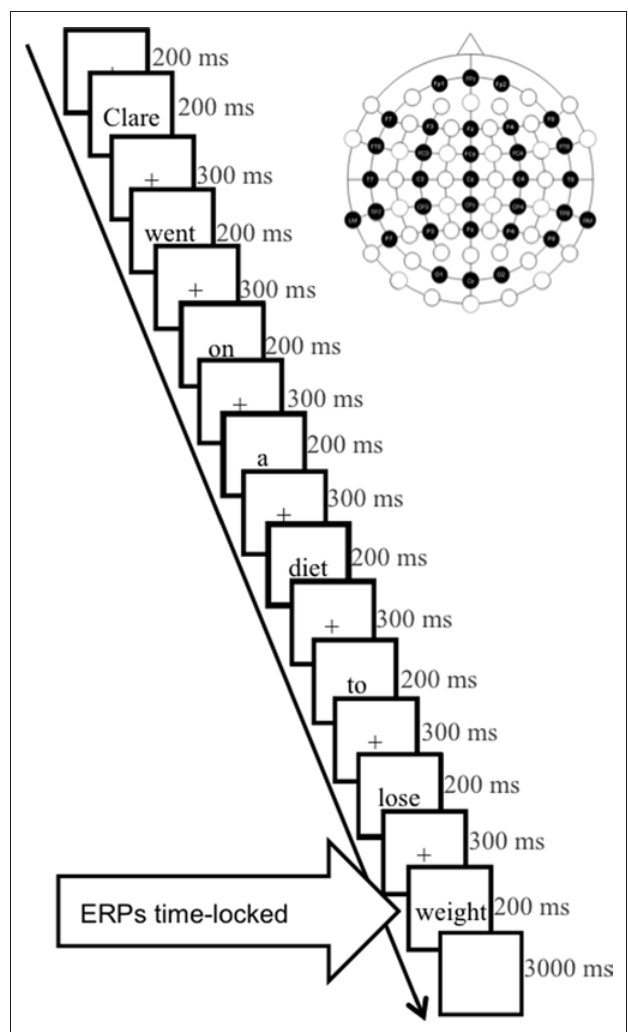
FiGure 1 | Schematic of a single